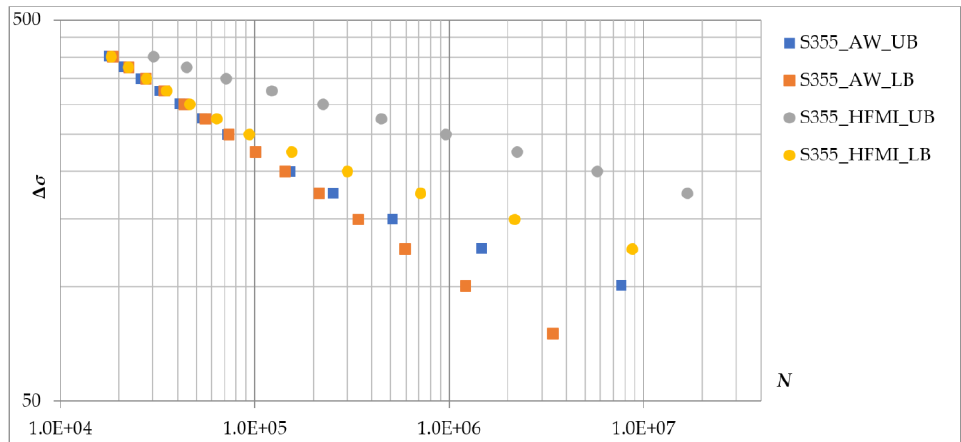
Figure 11. Results of calculated fatigue life for S355 (AW and HFMI condition).